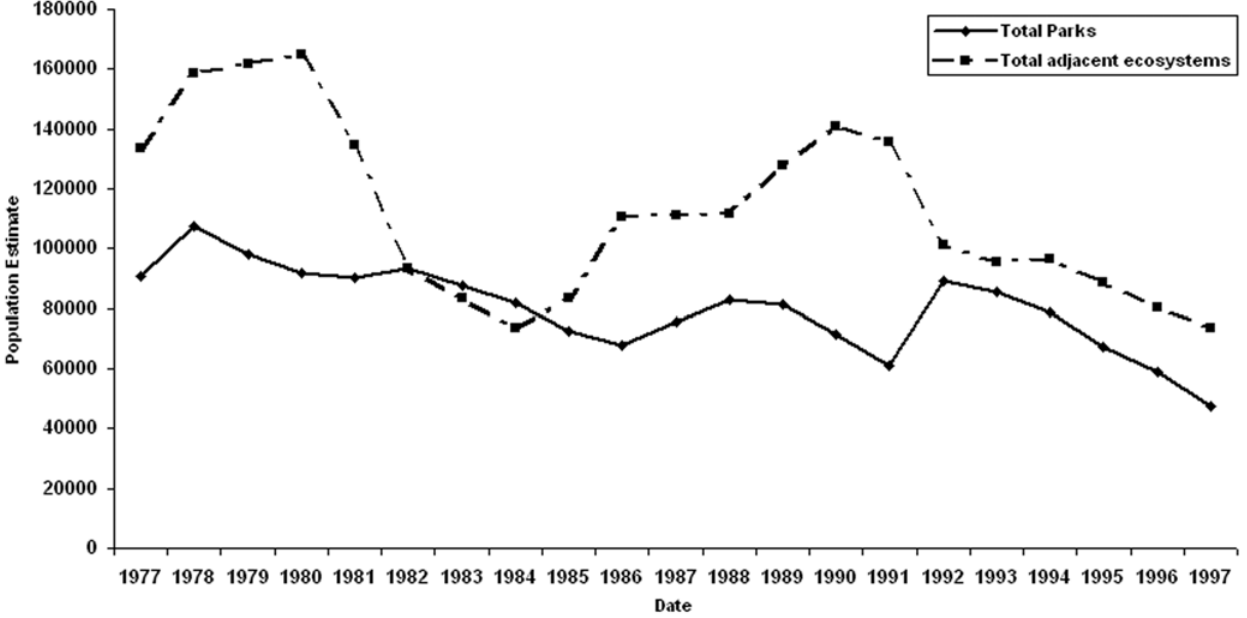
Figure 2. Total wildlife populations for national parks with matching external ecosystem counts. The parks include Tsavo East, Tsavo West, Amboseli, Nairobi but exclude Meru and Nakuru.